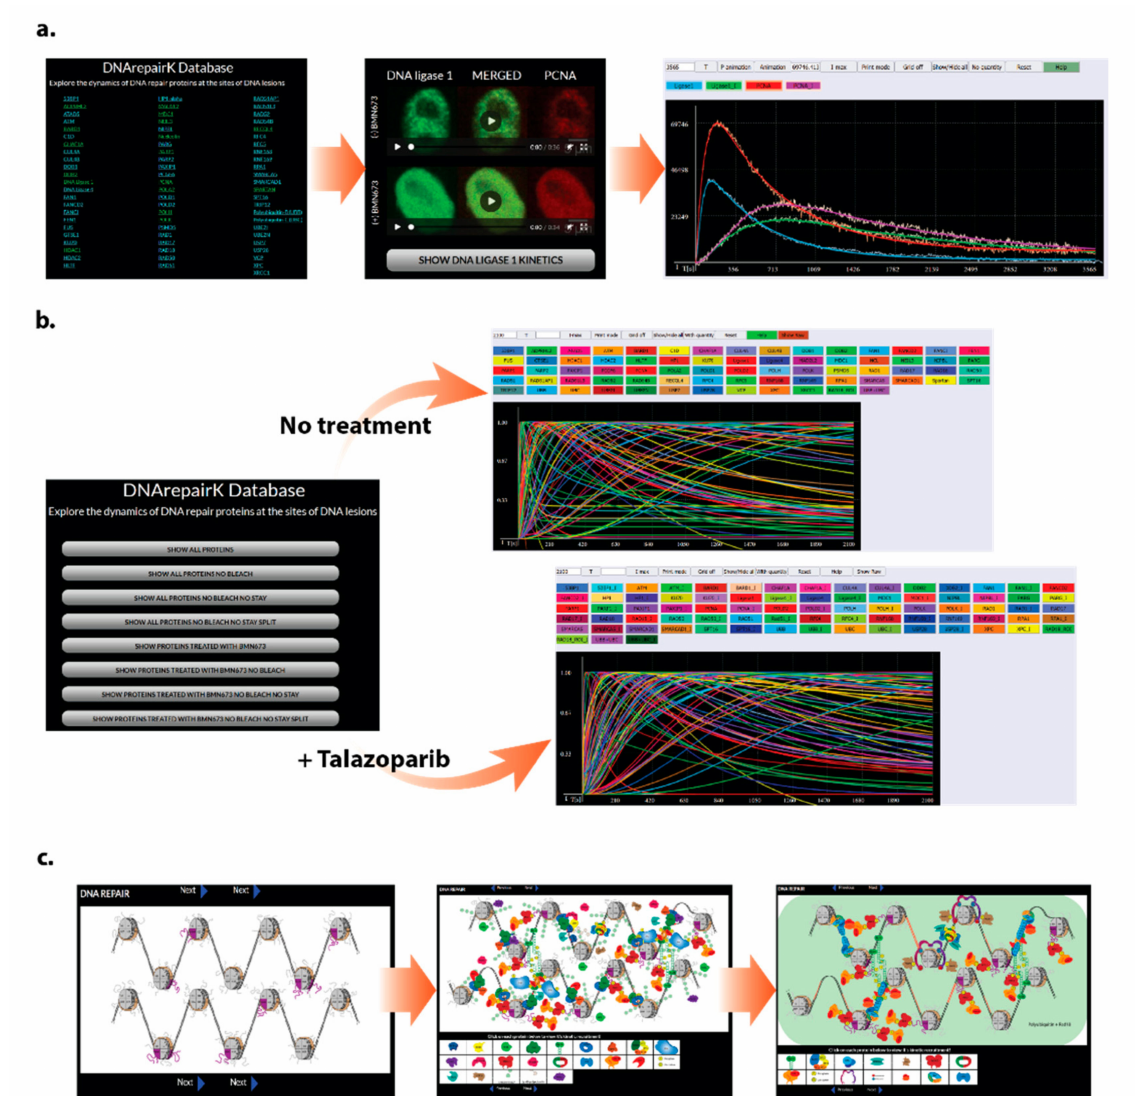
Figure 5. Structure of the DNArepairK database. ( a ) Kinetics of individual proteins. This part of the database contains the kinetics of all studied proteins accompanied by their CRC models and time lapse movies depicting their recruitment and removal at complex DNA damage sites in living cells. ( b ) Kinetics of all the proteins. The second section allows the user to comfortably compare the kinetics of all investigated proteins with and without talazoparib treatment. ( c ) Interactive pictures. The last section represents an interactive slideshow of the events in the course of DNA repair based on the kinetics data included in the DNArepairK